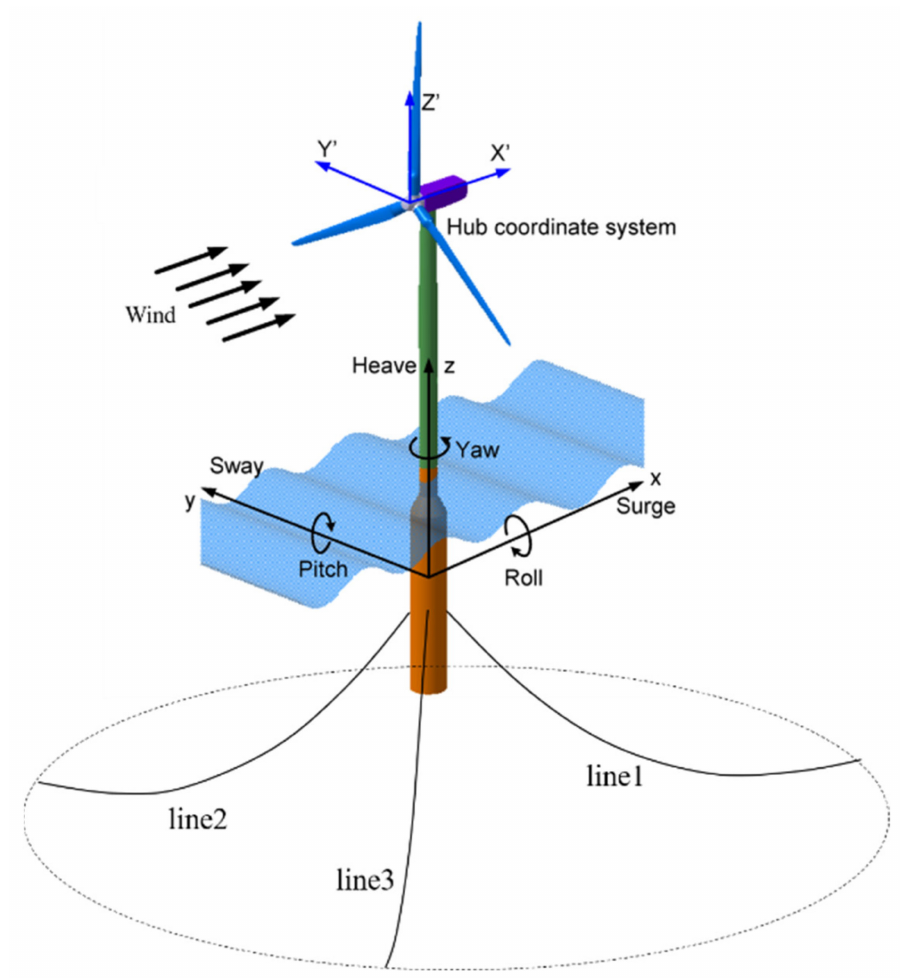
Figure 4. A sketch of the coordinate system in